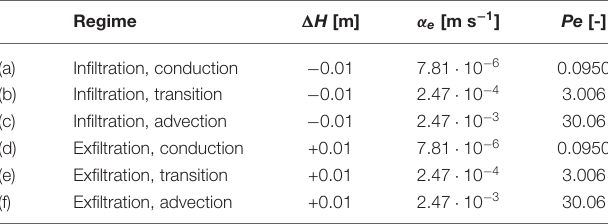
Table 4 . Underlying “true” parameters α e and κ e , used to generate the synthetic observed temperature time series θ ∗ , are represented with a wide dot. The thick solid line represents the set of parameters corresponding to Pe = 1, that is the separation between HZ properties corresponding to a conductive regime (left of the line) and properties corresponding to an advective regime (right of the line). TABLE 4 | Hydrological and thermal configurations in synthetic case